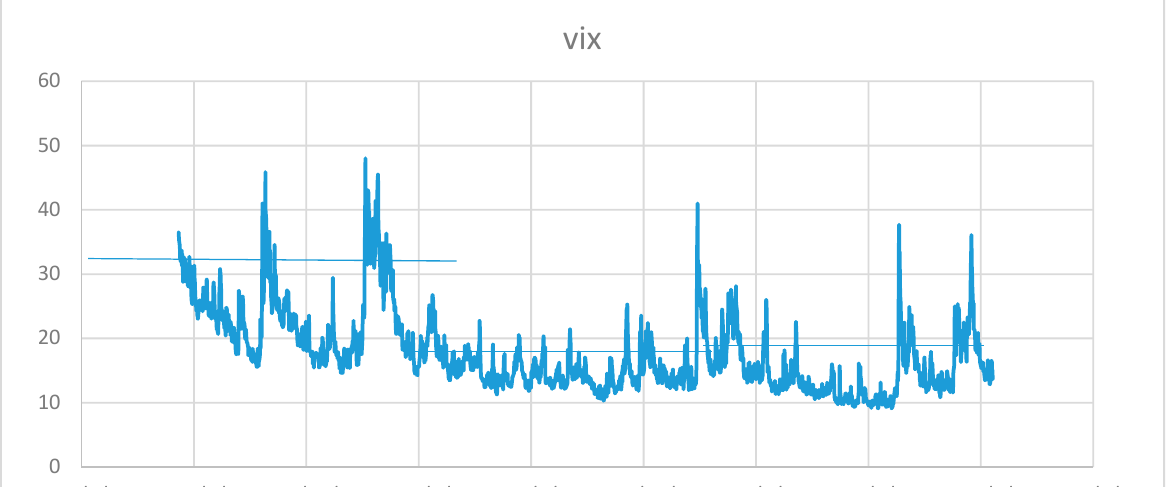
Figure 3. VIX and major breaks.